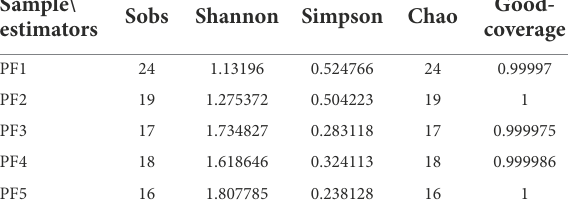
TABLE 2 Molecular identification of strains isolated from the surface of the pottery figurines. Fungi Molecular identification results